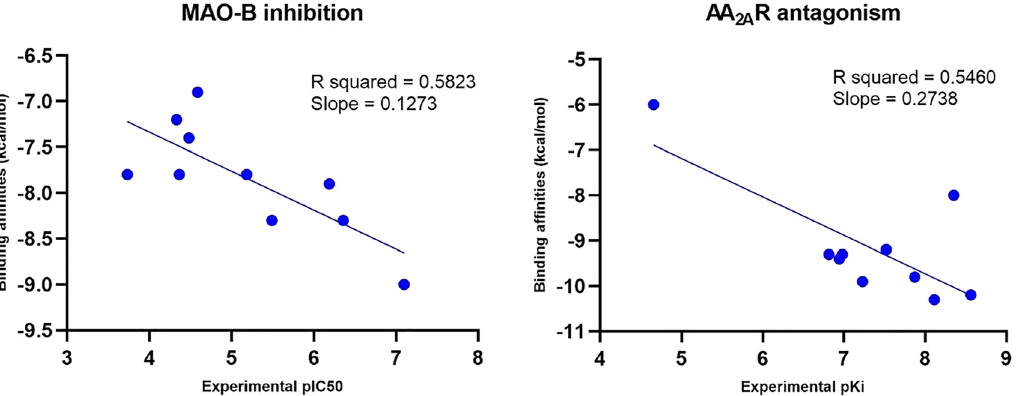
Figure 6: Correlation chart between molecular docking results and experimental pIC50 for MAO-B (left) and experimental pKi for R AA 2A